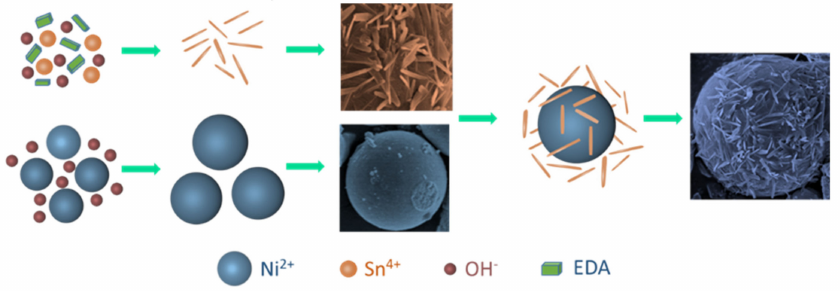
Figure 6. Schematic diagram of the possible growth mechanism of the SnO 2 / NiO